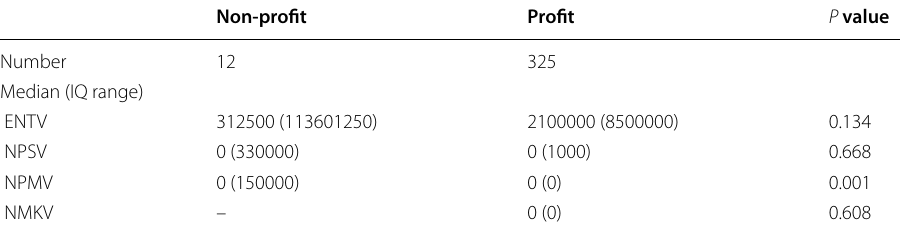
Table 8 Differences between profit-oriented organisations and non-profit-oriented enterprises in the value of innovations carried out